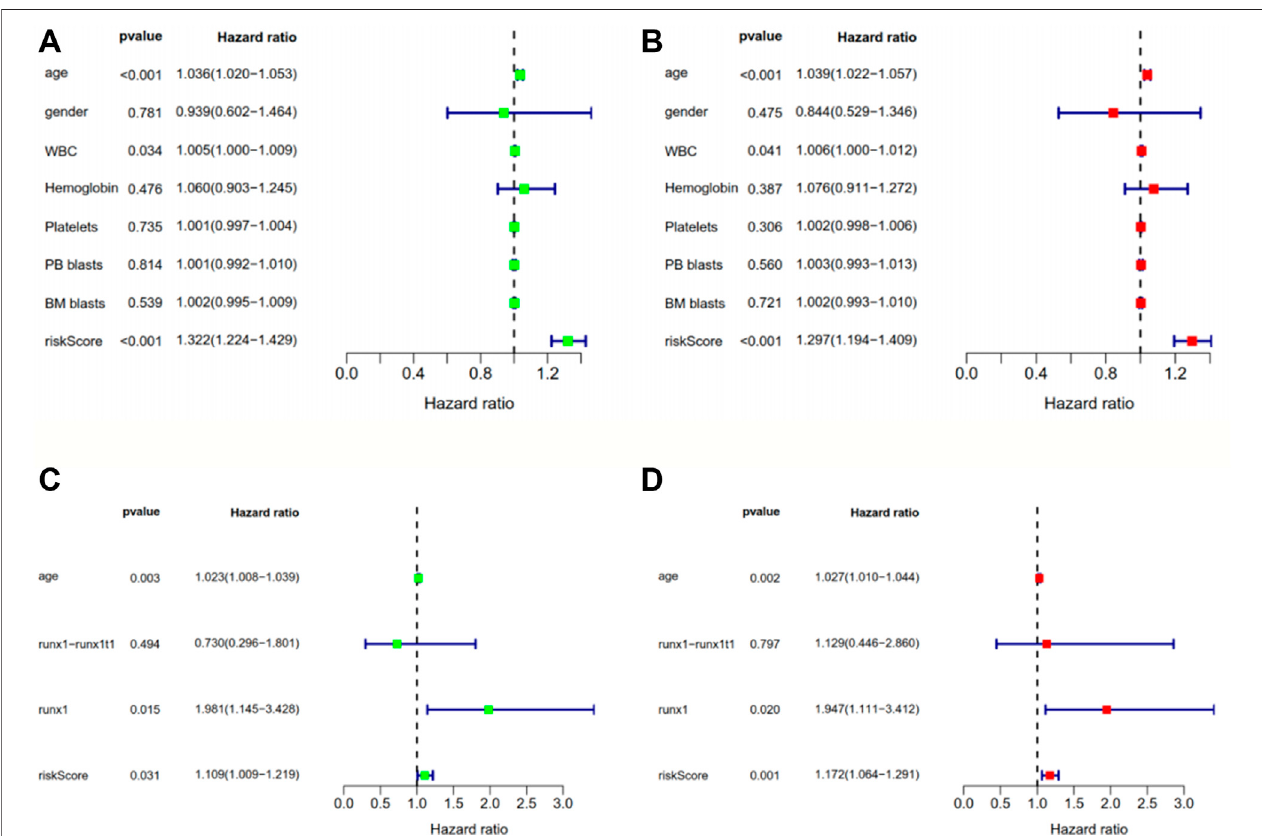
FIGURE3| Univariate (A,C) andmultivariate (B,D) CoxregressionanalysesofclinicalinformationandriskscoresinthetraininggroupTCGA-LAML (A,B) andthe validation group GSE37642-GPL570 (C, D) . p < 0.05 indicates that a factor isassociated with the overall survival of AML. HR > 1 indicates the factor is a high-risk factor and isnegativelycorrelatedwiththeprognosisofAMLpatients.Theriskscoreobtainedfromthemodelwasfoundtobeanindependentprognosticfactor, with p < 0.05 in both the univariate and multivariate analyses. TCGA, The Cancer Genome Atlas; AML, acute myeloid leukemia; HR, hazard